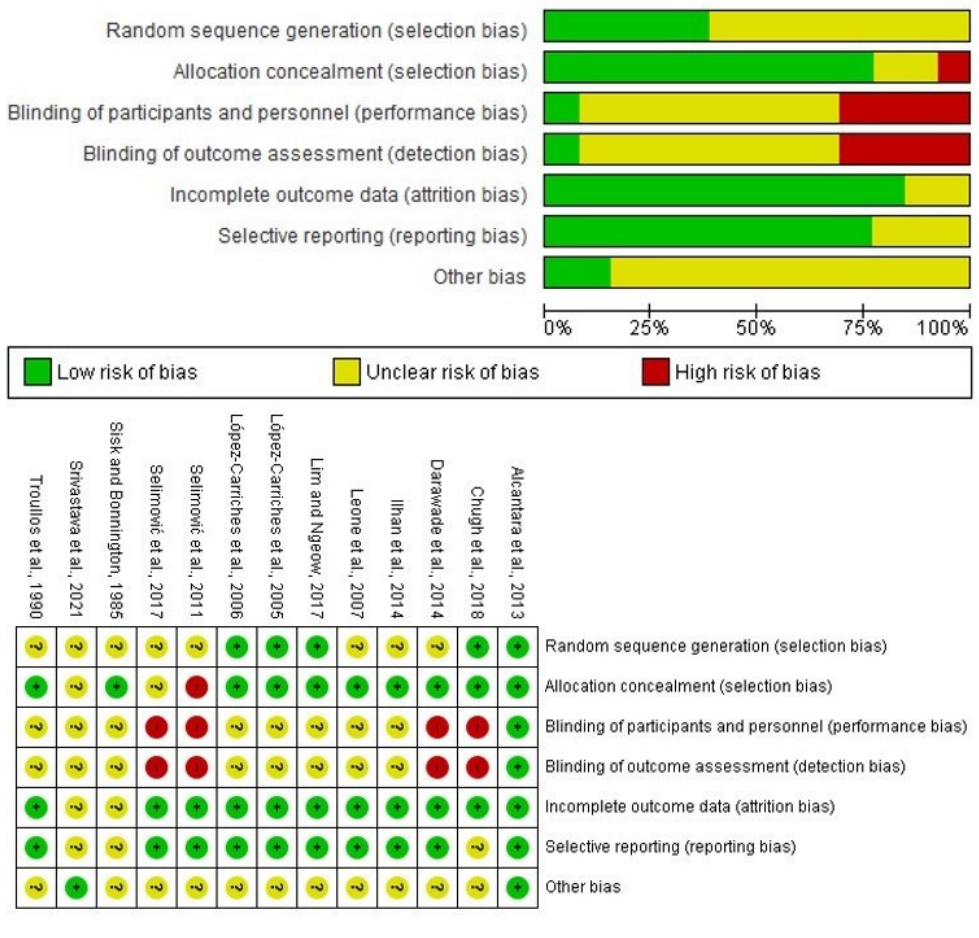
Figure 2. Bias evaluation of the full ‐ text articles [19–31].